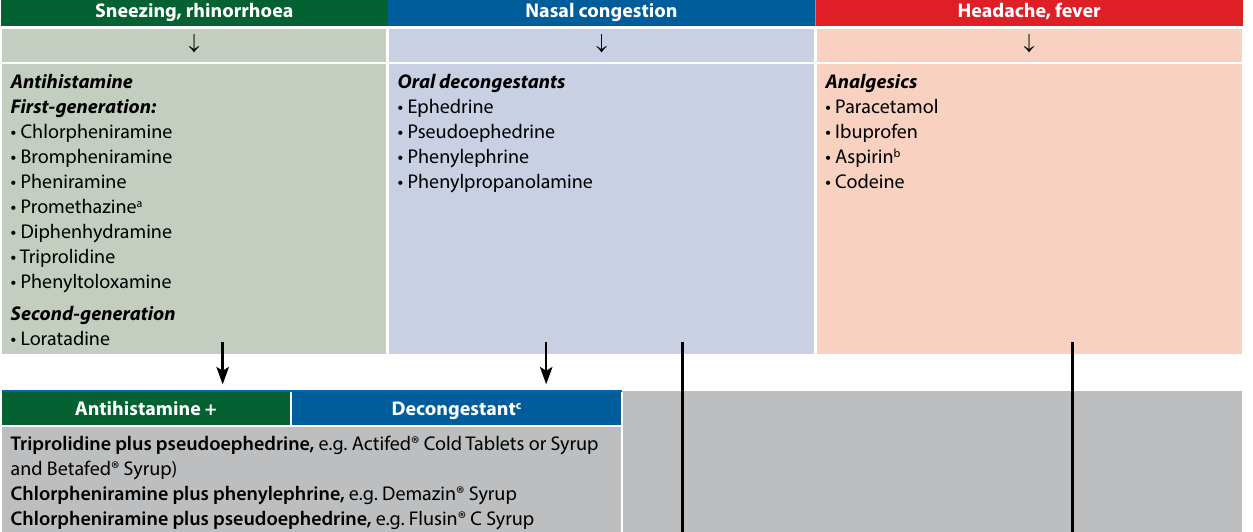
Table I: Symptom-based assessment for over-the-counter cold and flu medicines Sneezing, rhinorrhoea Nasal congestion Headache, fever